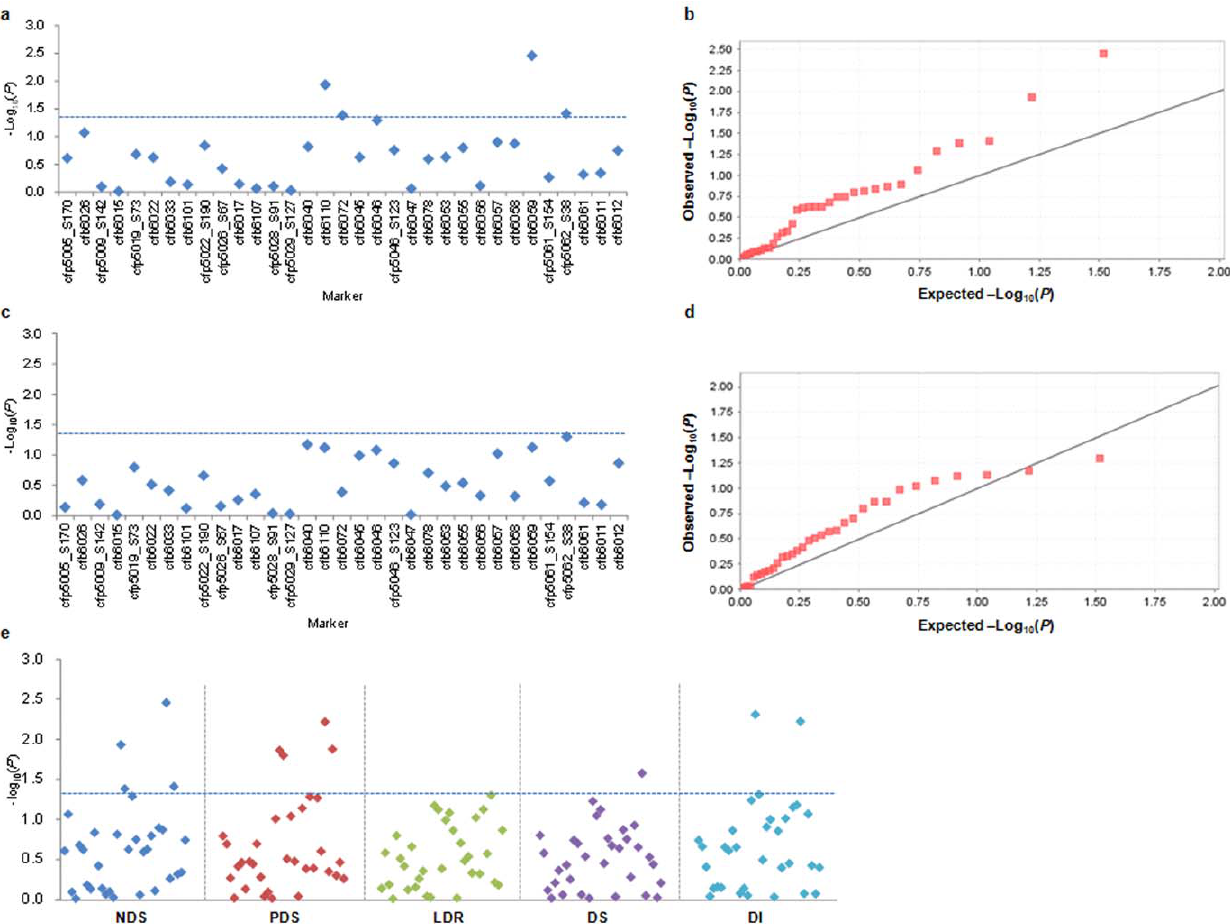
Figure 3. Associations of five FHB-related traits with molecular markers in the 3.1 -Mb genomic region. (a) Dot plots of the compressed mixed linear model (MLM) for numbers of diseased spikelets (NDS). Negative log 10 -transformed P values in a sequenced contig ( ctg954 ) of 3.1-Mb are plotted against position along the chromosome region. Blue horizontal dashed line represents the chromosome-region significance threshold. (b) Quantile-quantile plot of compressed MLM for NDS. (c) Dot plots of compressed MLM for lengths of diseased rachides (LDR), as in a. (d) Quantile- quantile plot of compressed MLM for LDR. (e) Dot plots of compressed MLM for five FHB phenotypic traits, i.e. number of diseased spikelets (NDS), percentage of diseased spikelets (PDS), the length of diseased rachides (LDR), disease severity (DS) and disease index (DI), as in